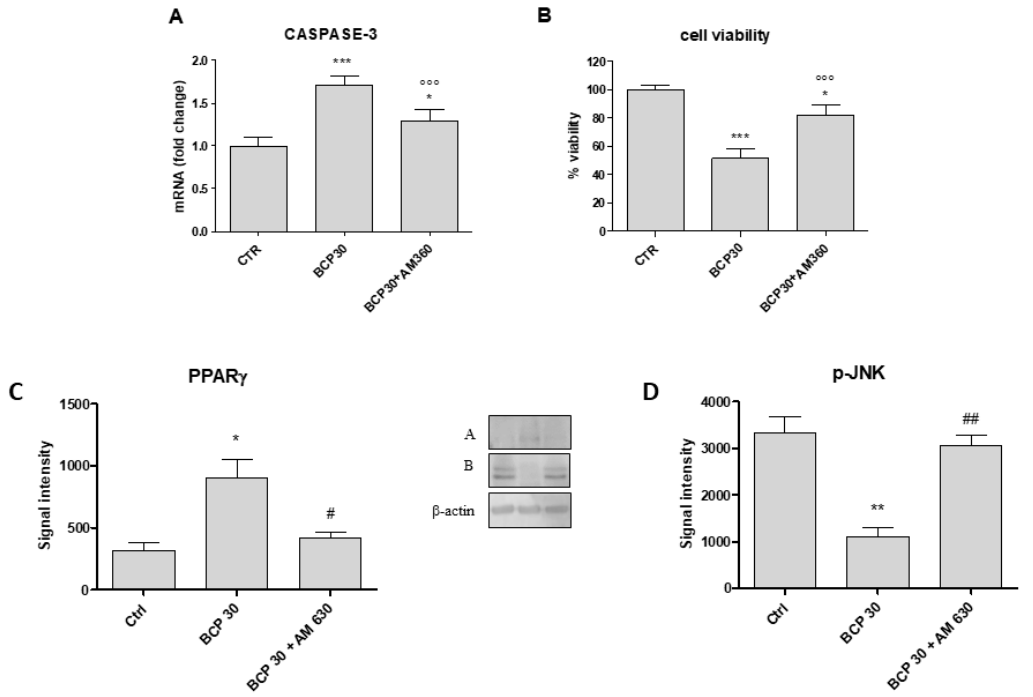
Figure 5. Graphs represent caspase-3 gene expression ( A ), cell viability ( B ), and the protein expression of PPAR γ ( C ) and pJNK ( D ) in U373 cells untreated and treated with BCP at the dose 30 µ g / mL and BCP (30 µ g / mL) + AM630, cannabinoid receptor 2 (CB2) receptor antagonist. After densitometric analysis data are expressed as signal intensity and means ± SD. * p < 0.05 and ** p < 0.01 vs. the control and BCP + AM630; ◦◦◦ p < 0.001 vs. BCP 30; # p < 0.05 and ## p < 0.01 vs. BCP30. *** p <